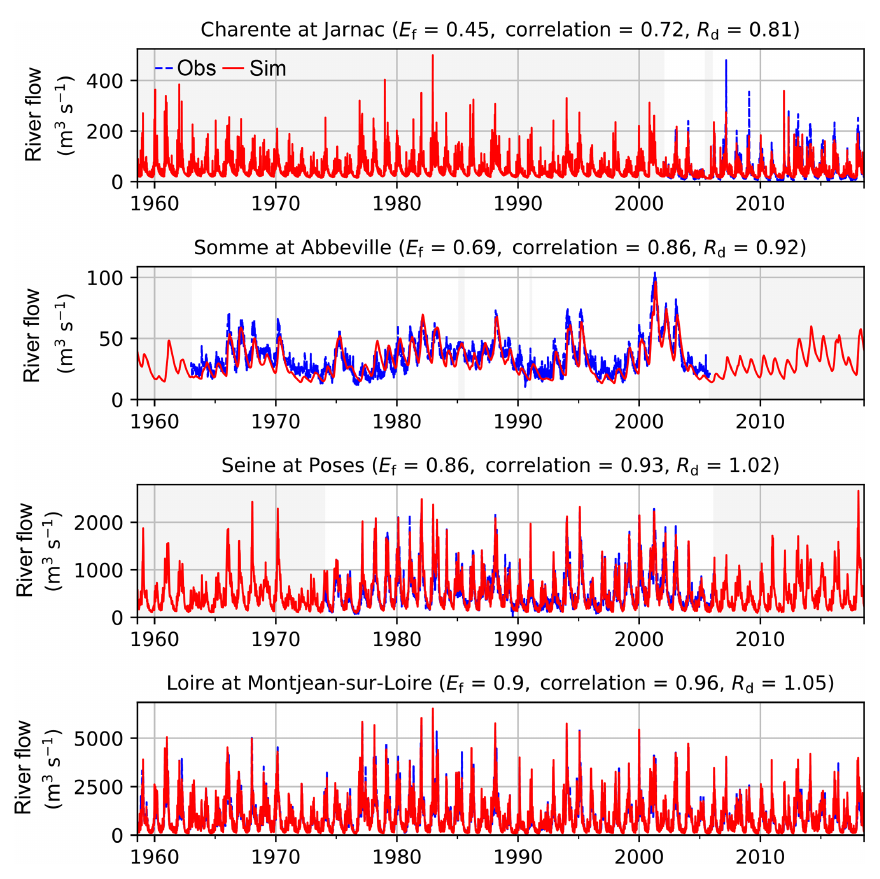
Figure 13. Daily observed (dashed blue) and simulated (red) river flows for the four gauging stations encircled in yellow in Fig. 3. E f , correlation and ratio ( R d ) scores are given in parenthesis for each gauging station. Grey backgrounds correspond to periods of gaps in the